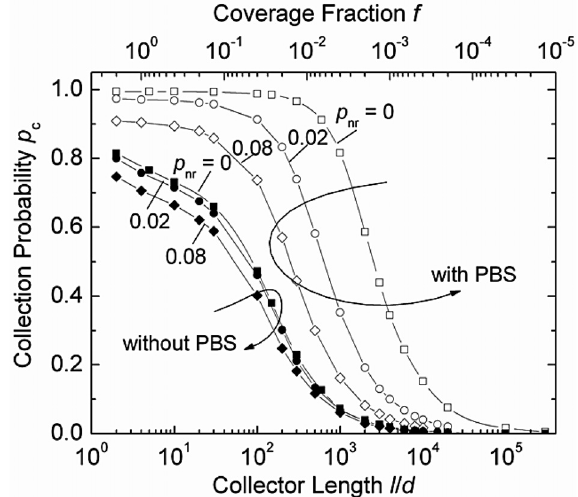
Fig. 4. The collection probability p c of the classical fluores- cent collector geometry (Fig. 1a) fully covered with solar cells at its sides depends on the collector length l normalized to the thickness d . A perfect mirror covers the back side. The systems with a photonic band stop filter (PBS, open symbols) have higher collection probabilities than those without PBS (filled symbols). For the system with PBS a value of p c close to unity remains up to a normalized collector length l/d ≈ 500 and non- radiative recombination probability p nr = 0 in the dye. In con- trast, the system without PBS has a maximum p c only slightly above 80% even in the radiative case with p nr = 0. With in- creasing collector length l/d the collection probability p c de- creases immediately. The consideration of non-radiative recom- bination in the dye, i.e. p nr > 0, leads to a deterioration of p c in all cases. The cell coverage fraction f (top axis) is directly linked to the collector size for the chosen